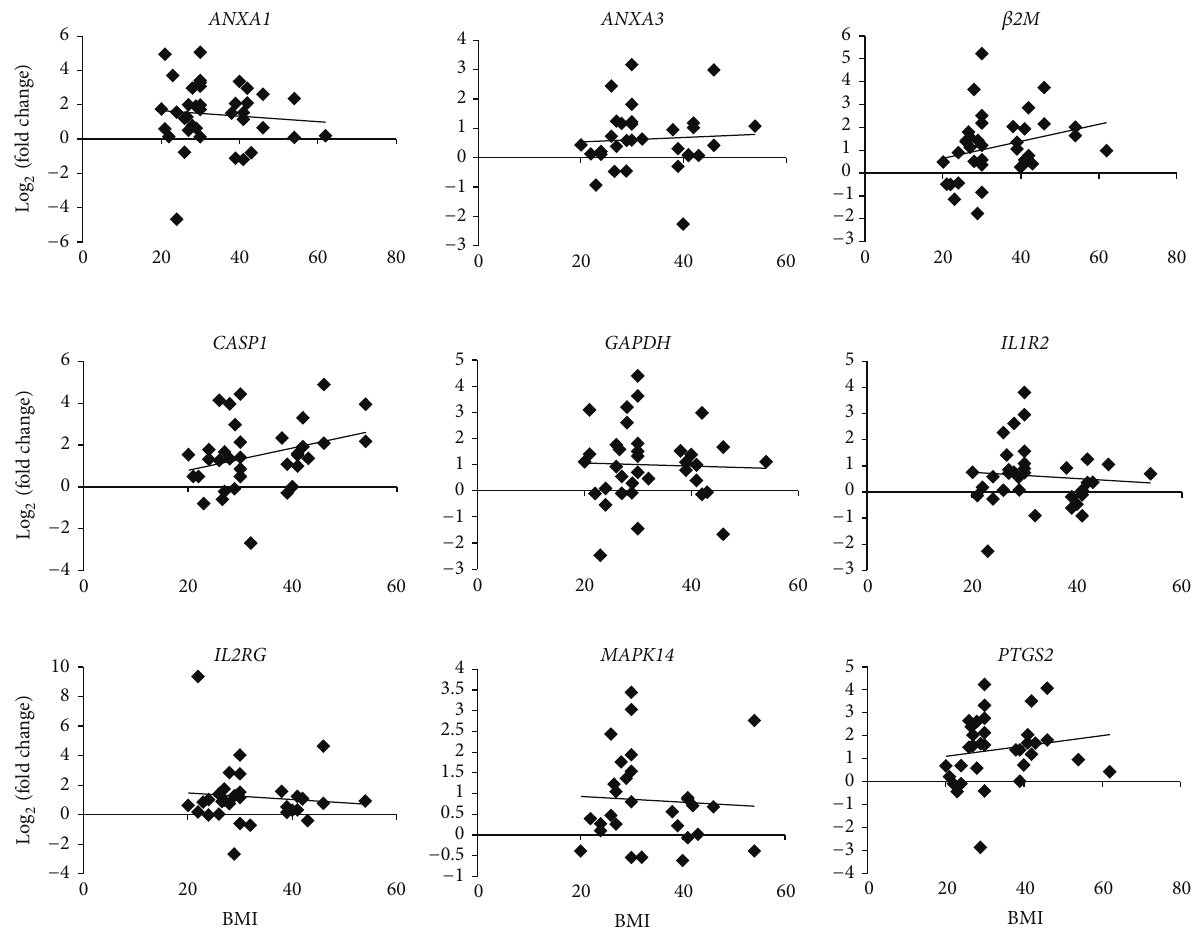
Figure 1: Correlation of transcript levels with BMI. The transcript levels were plotted against the log values of the transcript levels for each of the transcripts that were significant in the sleep apnea or “sleepy” groups. In addition the transcripts with the lowest 𝑃 value were plotted to determine if there was a significant correlation with increased weight. For each transcript, there was no significant correlation with increased